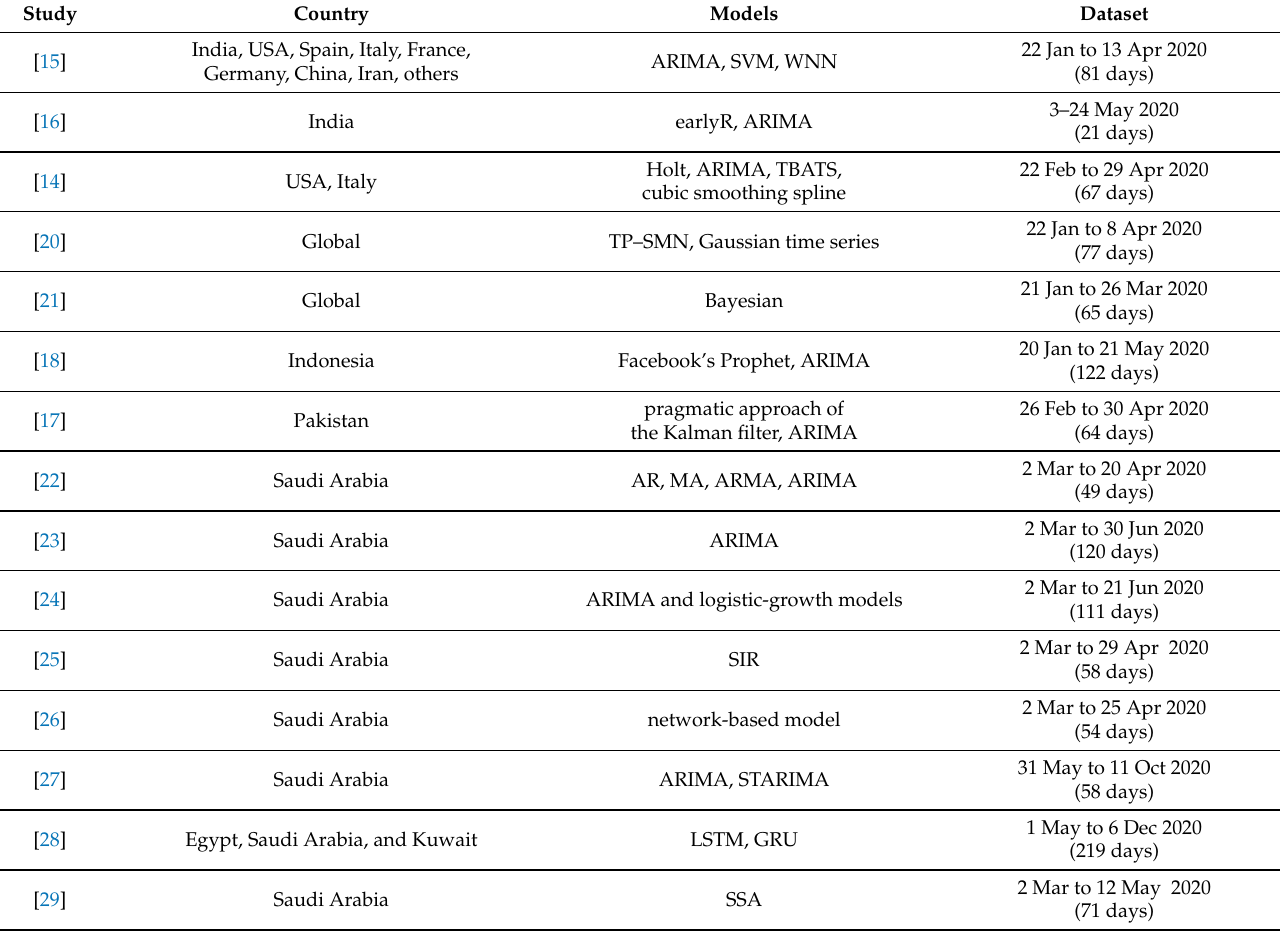
Table 1. Related work using time-series models for infectious-disease